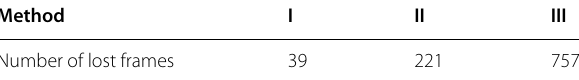
Table 5 The number of frames when a target is lost Method